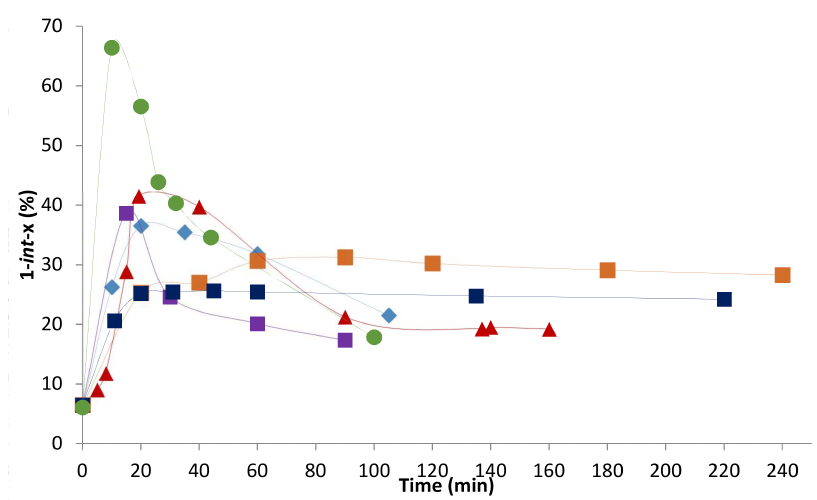
Figure 3. Influence of the [ 1 ] 0 /[Rh] ratio on the amount of internal isomers ( 1- int -x ) as a function of time in tandem isomerization-hydroformylation of 10-undecenitrile ( (cid:4) [ 1 ] 0 /[Rh] = 20,000 (1.0 M), (cid:4) [ 1 ] (cid:7) [ 1 ] (cid:78) [ 1 ] (cid:4) [ 1 ] 0 /[Rh] = 20,000 (0.4 M), 0 /[Rh] = 7000, 0 /[Rh] = 3000, 0 /[Rh] = 1000, [ 1 ] 0 /[Rh] =